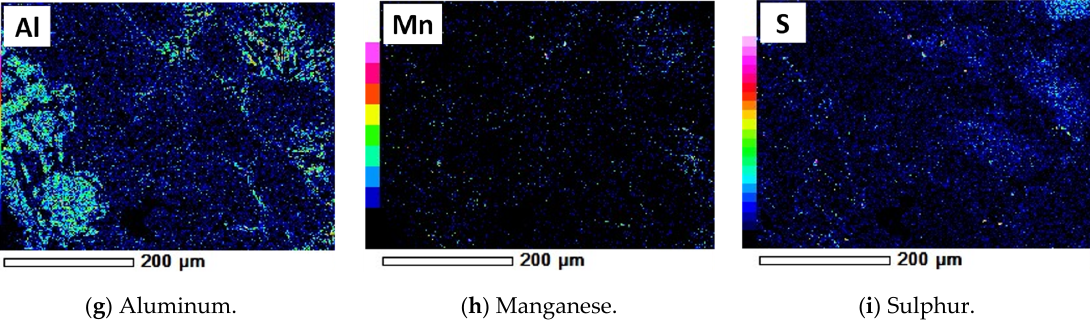
Figure 12. SEM-EDS elemental mapping of slag from the carbothermic reduction of the ilmenite concentrate at 30% Na 2 CO 3 addition, initial temperature of 1300 ◦ C, final temperatures of 1500 ◦ C, and heating rate of 6.6 ◦ C/min (pattern G). At 60% Na 2 CO 3 addition, trace of residual iron droplets was also observed in the slag (Figure 13). Titania-rich crystal was observed in the forms of large crystal and several thin needle-like crystals. The amorphous phase contained dominantly sodium, silicon, and aluminum and had more homogeneous appearance.